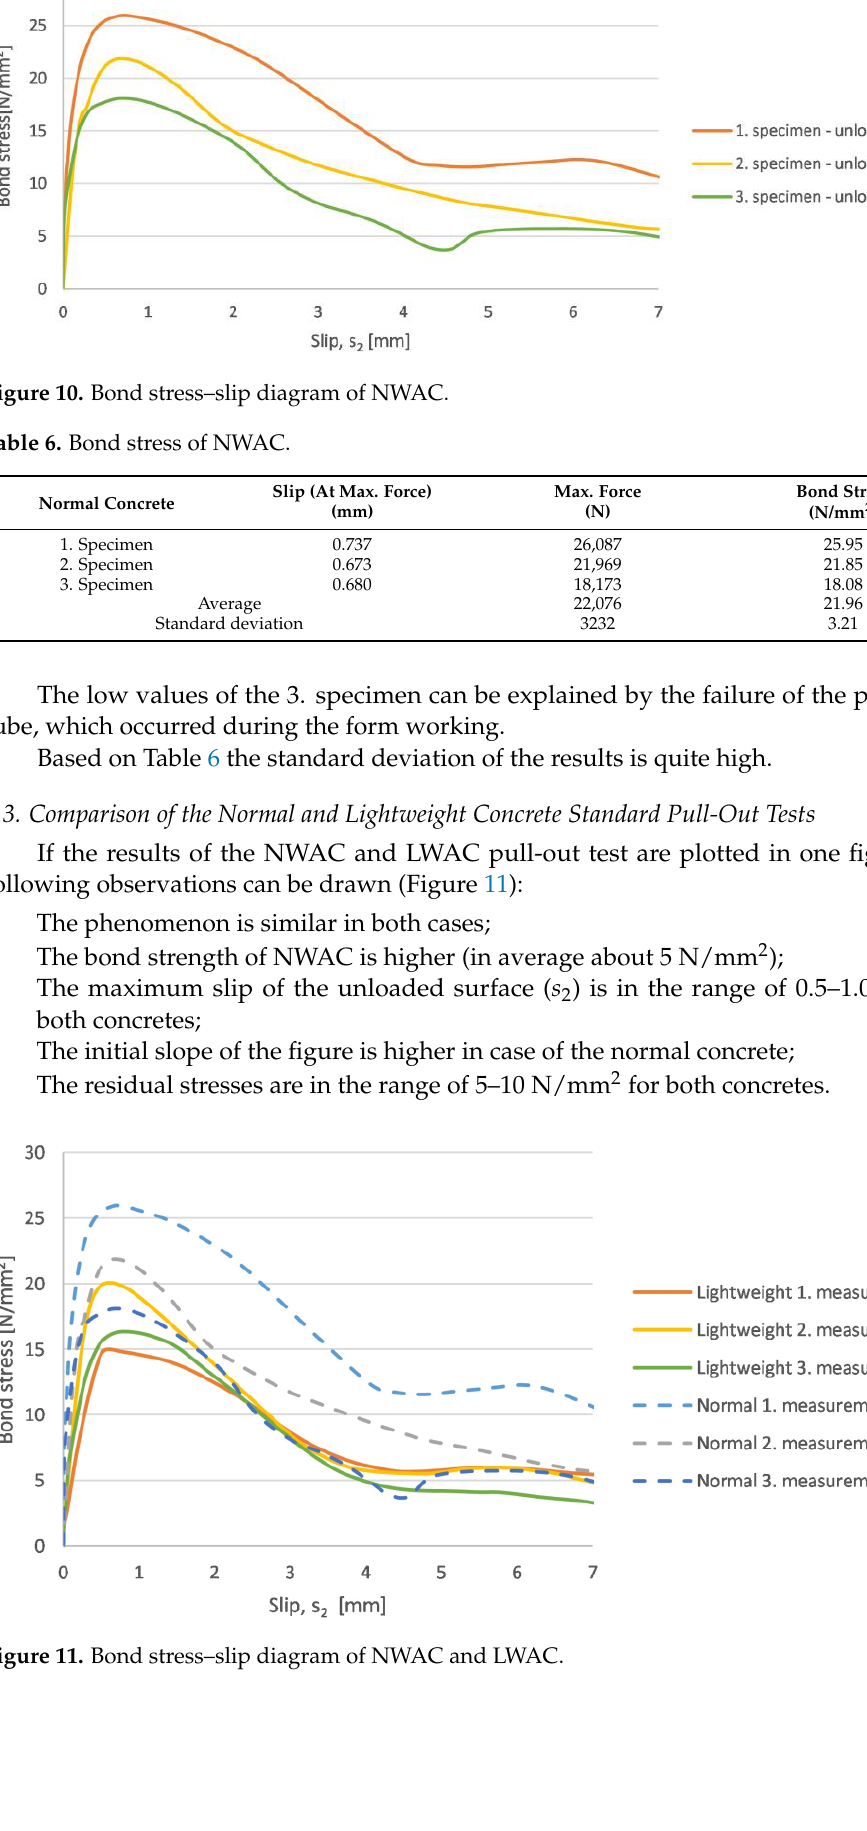
Figure 9. Results of the standard pull-out tests of NWAC.